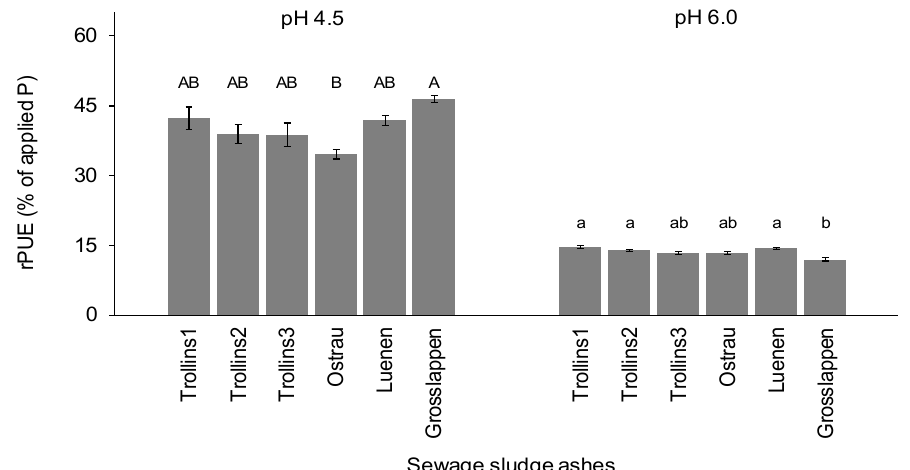
Figure 4. Relative phosphorus use efficiency (rPUE) of different types of sewage sludge ashes (SSA) at two contrasting pH levels in the growing medium. Different capital letters indicate differences (Tukey, p < 0.05) between the SSAs at pH 4.5, and lowercase letters indicate differences between the SSA at pH 6.0. Error bars represent the standard error of mean (n = 4). Table 4. CAT and CAL extractable amount of phosphorus (P CAT , P CAL ) in the growing media (mg pot − 1 ) of contrasting pH (4.5, 6.0) at the start and end of the trial, fertilized with sewage sludge ashes (Trollins1, Trollins2, Trollins3, Ostrau, Luenen, Grosslappen), water-soluble monocal- cium phosphate (MCP), and rock phosphate (RockP), respectively. Details of the sewage sludge ashes are summarized in Tables 1 and 2. Values at the end of the experiment are presented as the mean ± standard deviation (n =